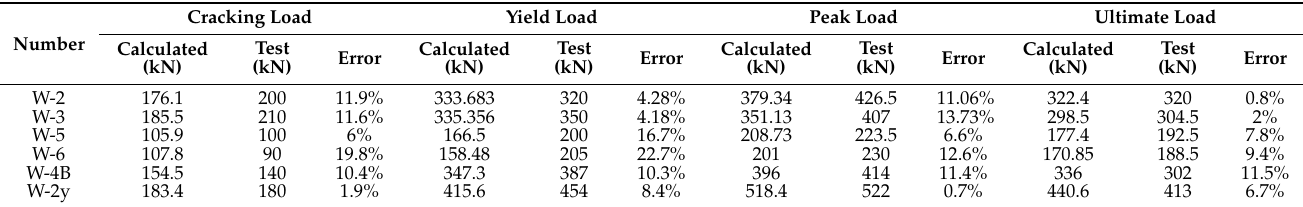
Table 2. Comparison of the calculated strength and test